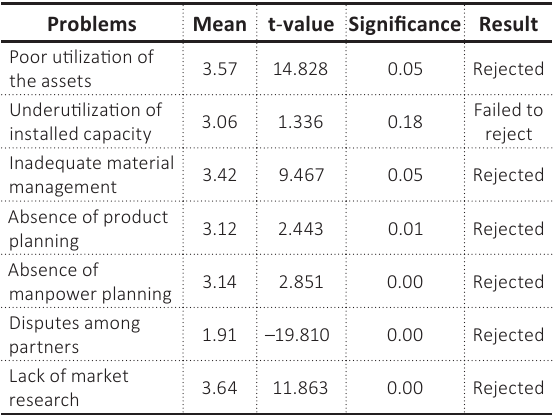
Table 13. Management-related